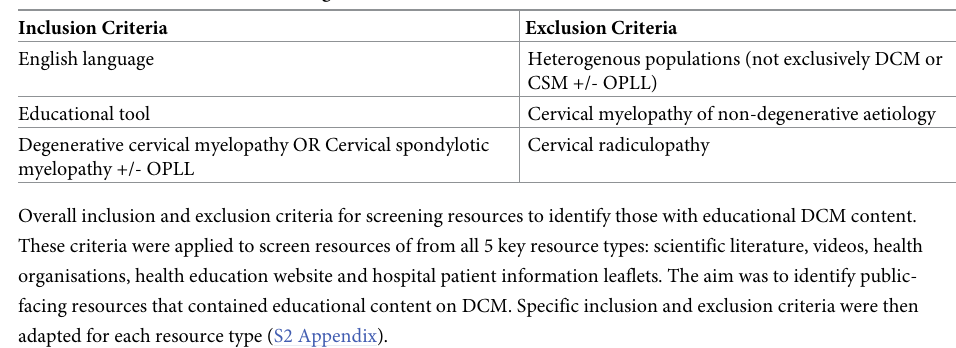
Table 2. Overall criteria for screening for DCM educational